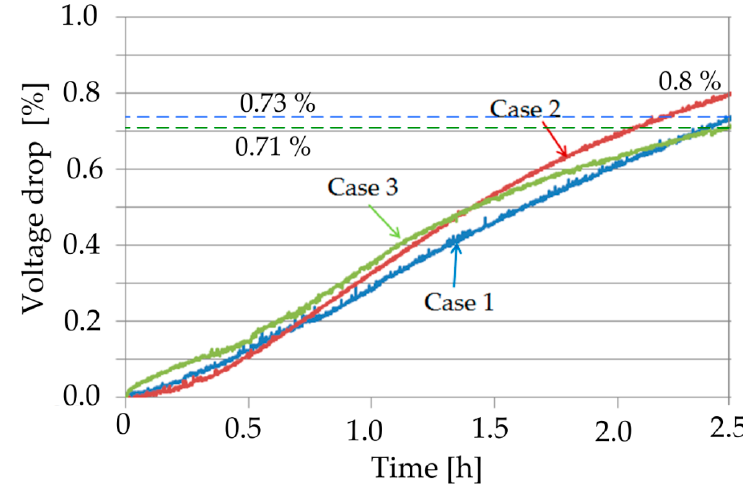
Figure 16. The percentage of the voltage drop of three cases (0–2.5 h).